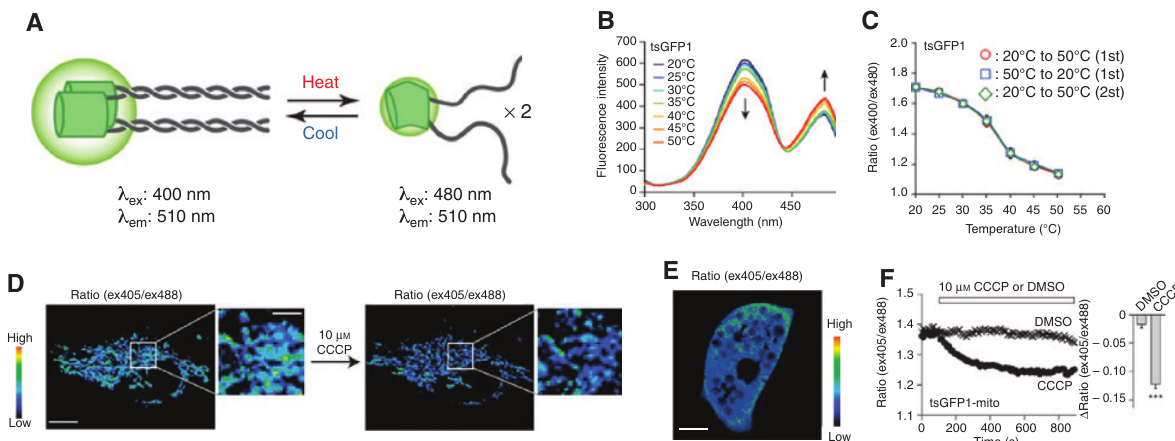
Figure 17: Monitoring of intracellular thermogenesis using a GFP-based thermometer tsGFP1. (A) Schematic diagram of tsGFP1, which consists of GFP (green) and coiled-coil regions of TlpA (gray). The tandem formation/deformation of the coiled-coil structure upon changes in the temperature resulting in a fluorescence change of tsGFP1. (B) Fluorescence excitation spectra = 510 nm). (C) Reversibility in the fluorescence intensity ratio of tsGFP1 in PBS. (D) Pseudocolor confocal images of the of tsGFP1 in PBS ( λ em fluorescence intensity ratio in a HeLa cell expressing mitochondria-targeted tsGFP1 before and after treatment with CCCP. Scar bars = 10 μ m (entire image) and 3 μ m (enlarged image). (E) Pseudocolor confocal images of the fluorescence intensity ratio in a brown adipocyte express- ing mitochondria-targeted tsGFP1. Scar bar = 10 μ m. (F) Fluorescence responses of a single brown adipocyte to 10 μ m CCCP (n = 28) and DMSO ***p = 4.8 × 10 − 6 using Student’s t-test. Reproduced with permission from Kiyonaka et al. (2013). Copyright 2013 Macmillan Publishers